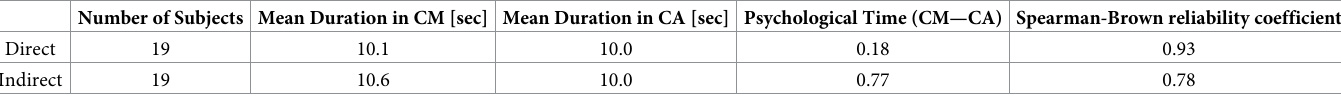
Table 4. Reliability of psychological